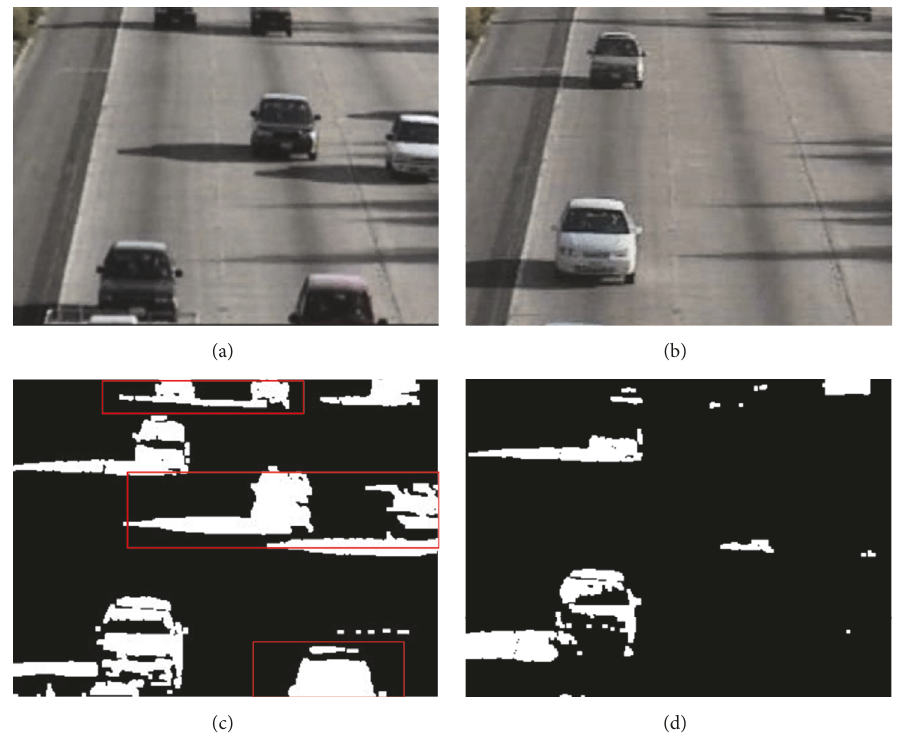
Figure 6: Comparison of ghost elimination. (a) and (b): the first and fiftieth frames of “Highway” video, respectively. (c) The detection result of the fiftieth frame by ViBe. (d) The detection result of the fiftieth frame by the proposed method.